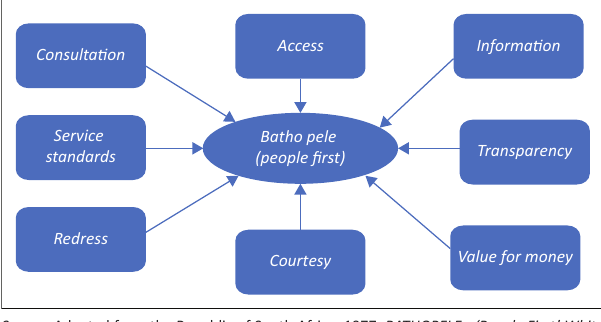
FIGURE 1: The eight principles of Batho Pele